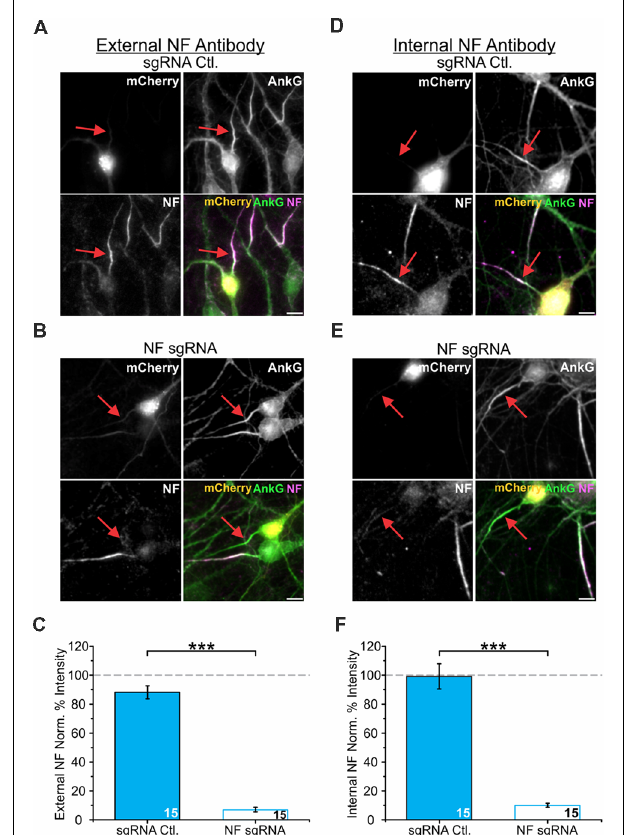
FIGURE 3 | NF single guide RNA (sgRNA) successfully depletes NF enrichment in the AIS. (A,B) Representative images of DIV14 sgRNA control (A) or NF sgRNA (B) neurons stained for mCherry, AnkG, and NF using an antibody targeting an extracellular domain of NF. Red arrows indicate the AIS of transfected neurons. Scale bar: 10 µ m. (C) Ratio of mean fluorescence intensity of NF at the AIS using an externally targeting antibody in sgRNA control or NF sgRNA expressing neurons, normalized to untransfected neurons in the same image ( n = 15 for both conditions; ∗∗∗ p < 0.001, Student’s t -test). (D,E) Representative images of DIV14 sgRNA control (D) or NF sgRNA (E) neurons stained for mCherry, AnkG, and NF using an antibody targeting an intracellular domain of NF. Red arrows indicate the AIS of transfected neurons. Scale bar: 10 µ m. (F) Ratio of mean fluorescence intensity for external NF at the AIS using an internally targeting antibody in sgRNA control or NF sgRNA expressing neurons, normalized to untransfected neurons in the same image ( n = 15 for both conditions; ∗∗∗ p < 0.001, Student’s t -test). Error bars indicate mean ±